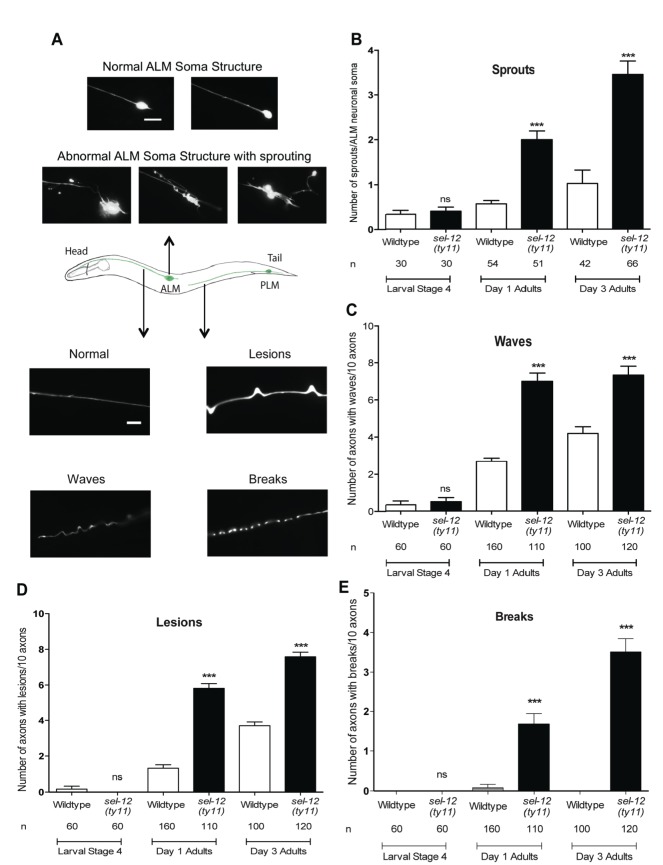
Loss of SEL-12 function results in neurodegeneration.(A) Representative images of normal ALM neuronal soma and abnormal soma with ectopic sprouting (above), cartoon depicting location of ALM and PLM neuron in C. elegans (middle) and representative images of wave-like processes, lesions and breaks observed in the ALM and PLM neuronal processes (below). Scale bar represents 10 μm. (B) Quantification of aberrant structures (sprouts/branches) on ALM neuronal soma at larval stage 4, day 1 and 3 of adulthood. Quantification of the frequency of wave-like processes (C), lesions (D) and breaks (E) in ALM and PLM neuronal processes in wild type and sel-12(ty11) animals at larval stage 4, day 1 and 3 of adulthood. Neuronal morphology analysis is done using transgenic animals expressing mec-4p::GFP (zdIs5). n = number of animals analyzed per genotype. Data are displayed as mean ± SEM, and all comparisons have been made to wild type animals unless otherwise indicated. ***p<0.0001 (One way ANOVA with Tukey test).10.7554/eLife.33052.007Figure 3—source data 1.Raw data for Figure 3.